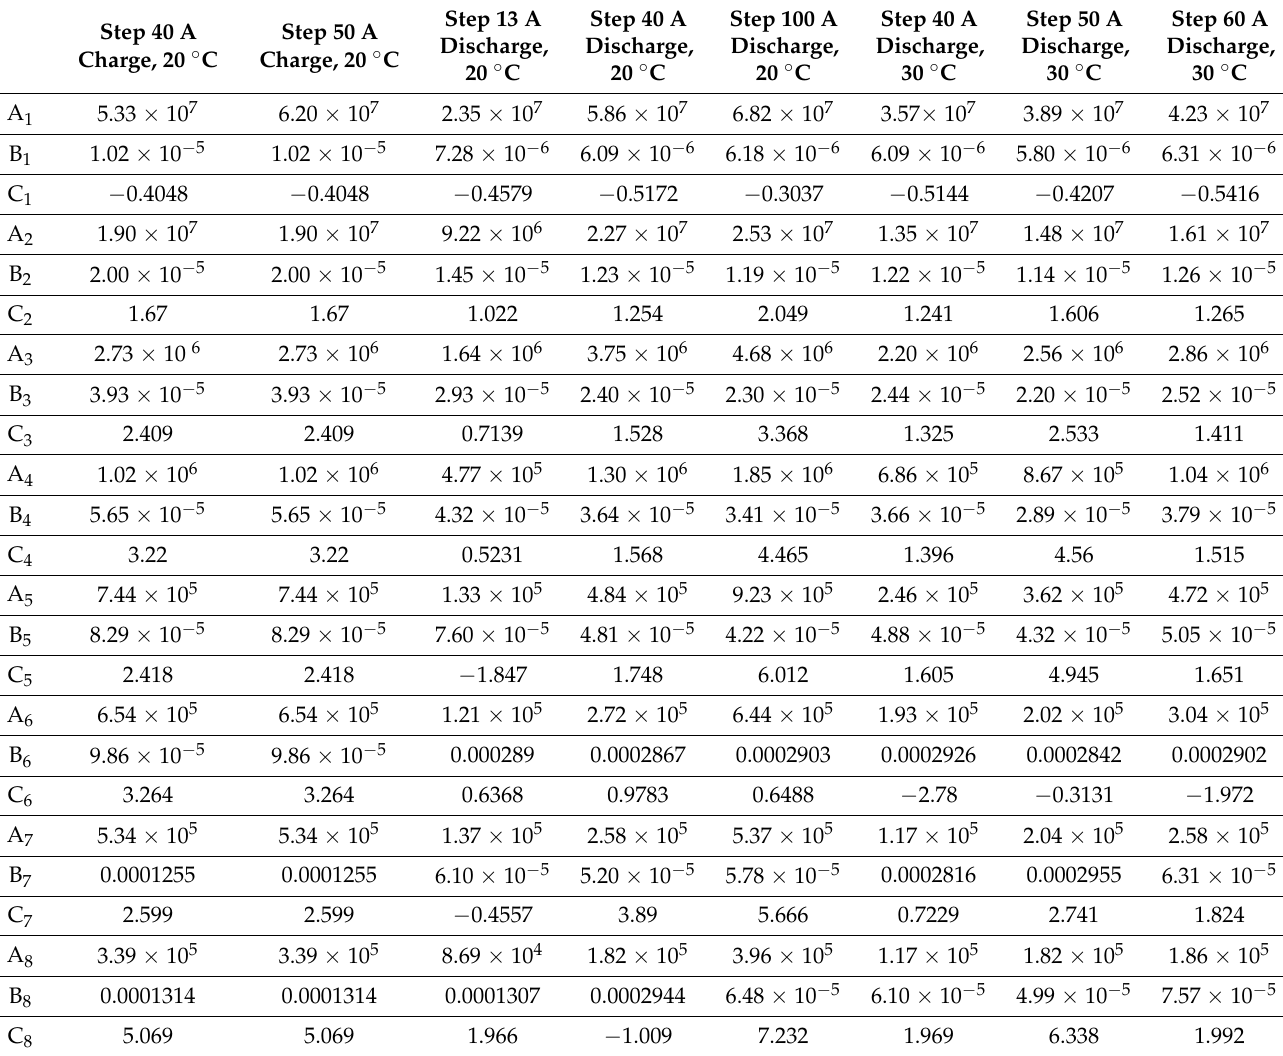
Table 5. Parameters of the total generated heat